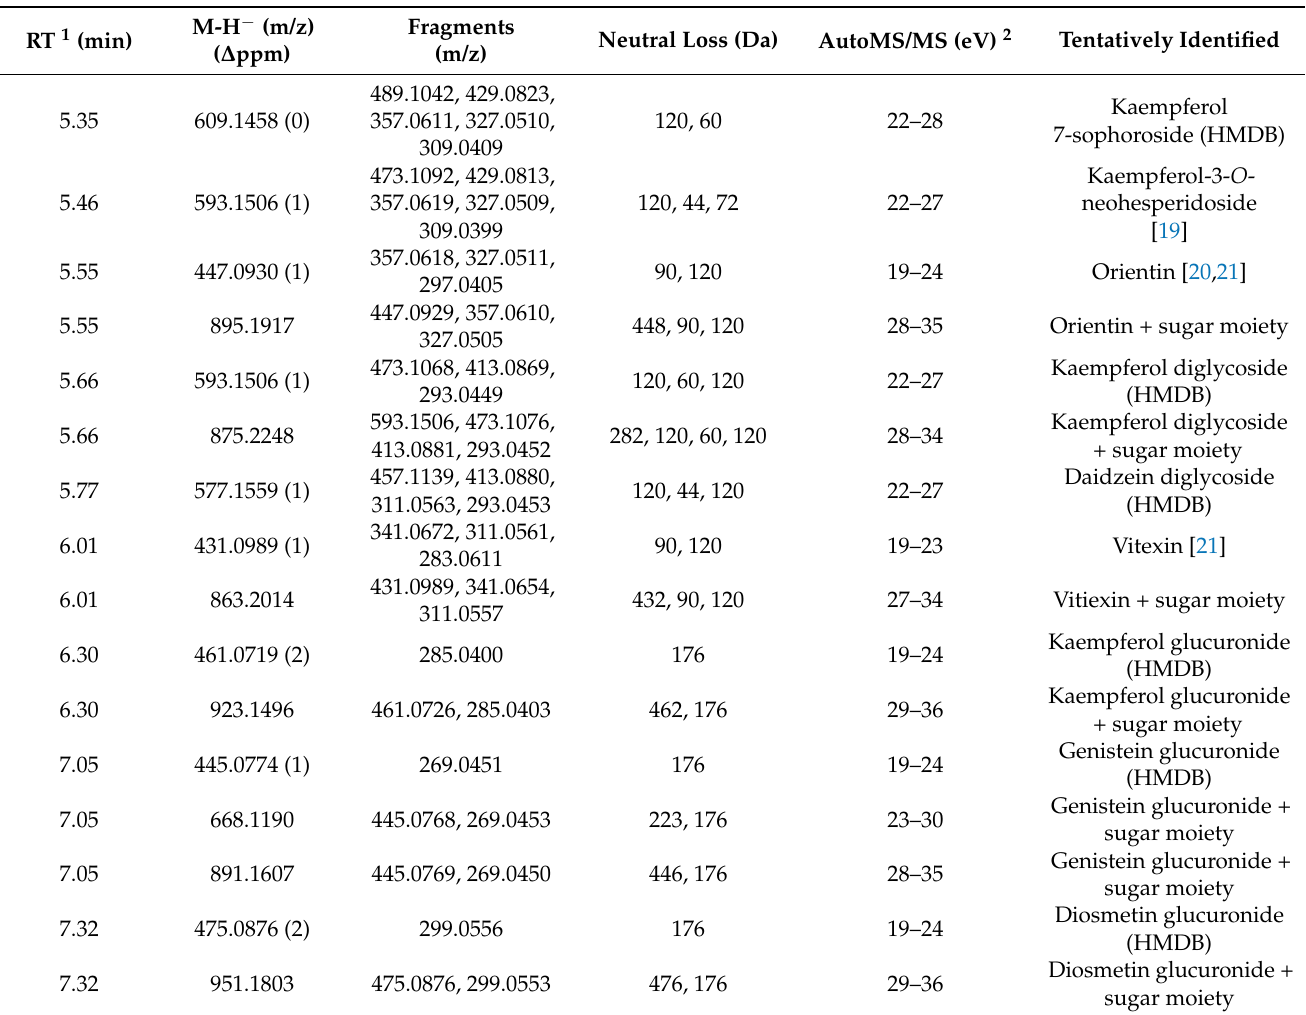
Table 2. Tentatively identified flavonoids glycosides in Cannabis sativa L. Futura 75